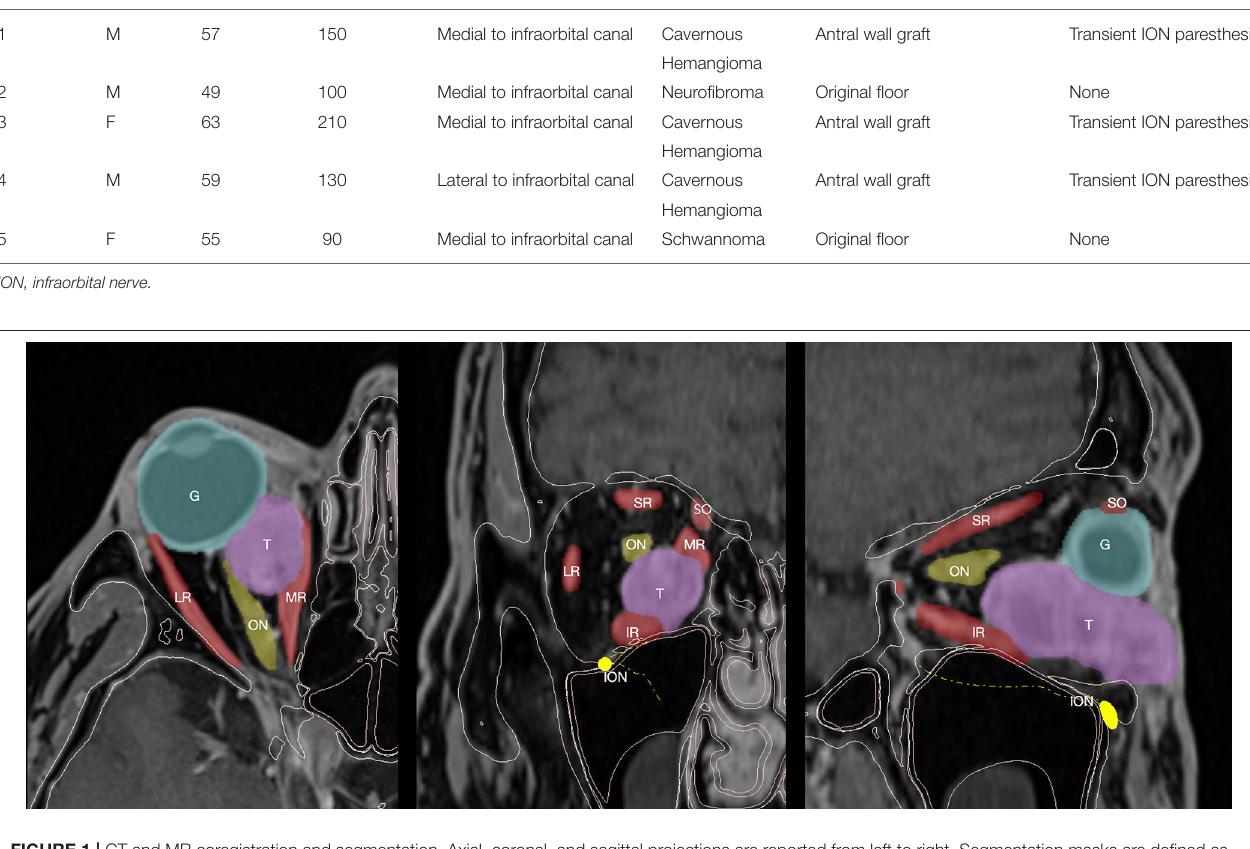
FIGURE 1 | CT and MR coregistration and segmentation. Axial, coronal, and sagittal projections are reported from left to right. Segmentation masks are defined as follows: the eye globe (G), tumor (T), optical nerve (ON) and infraorbital nerve (ION), extraocular muscles, including superior rectus (SR), lateral rectus (LR),